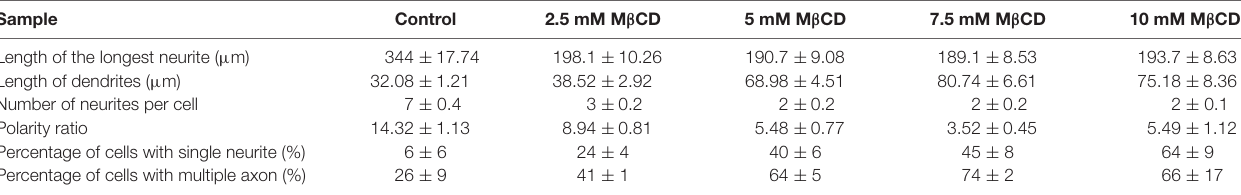
TABLE 3 | Developmental alterations of rat hippocampal neurons upon transient sequestering of cholesterol for 20 min.